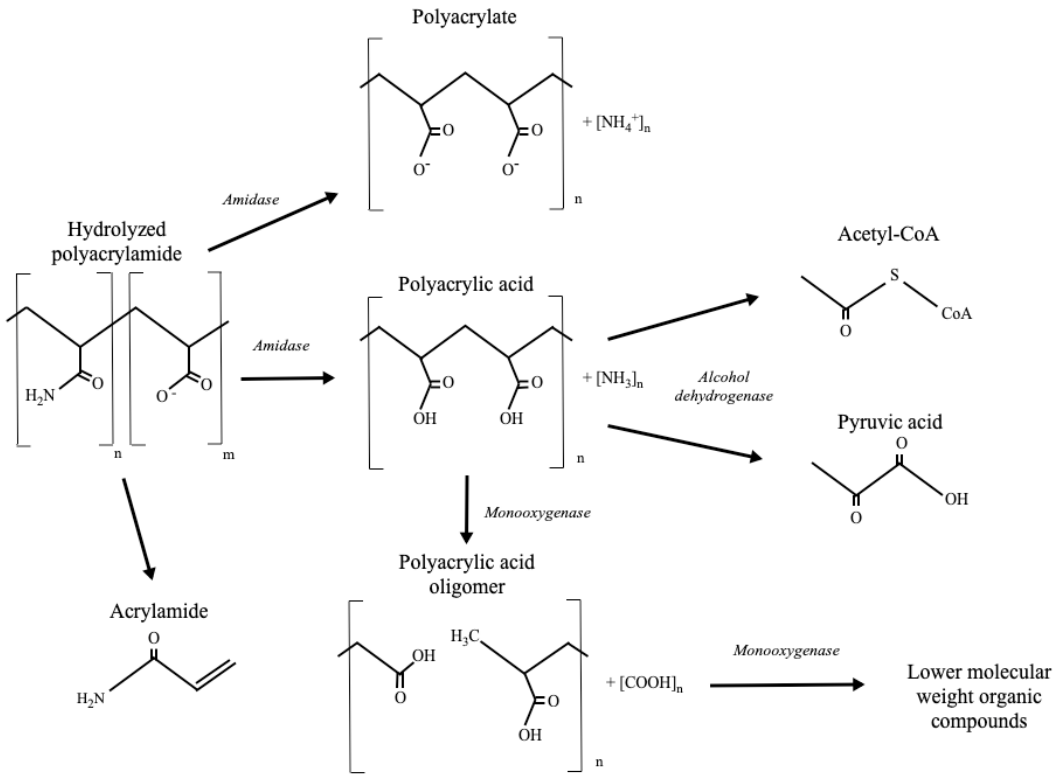
Figure 3. Potential biodegradation pathways of partially hydrolyzed polyacrylamide in oil sands tailings.